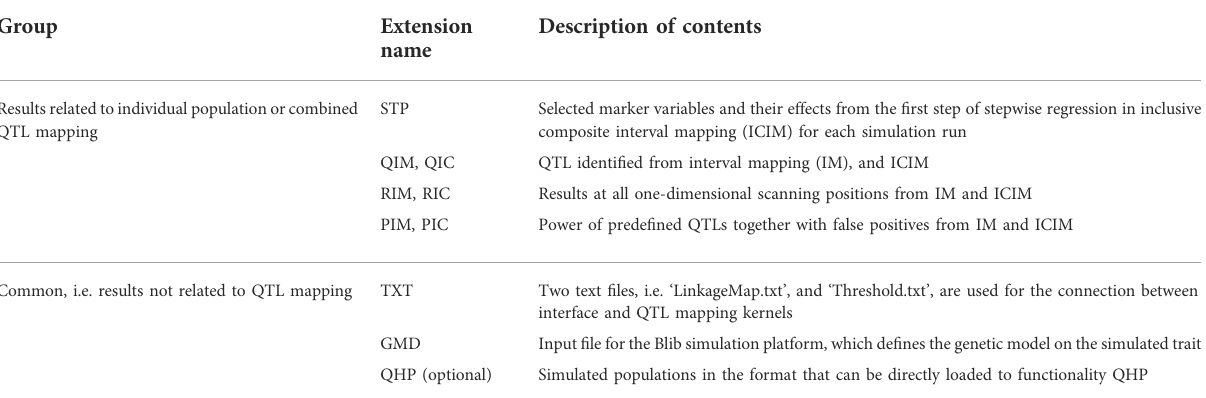
TABLE 3 Description of output fi les from the SHP functionality.